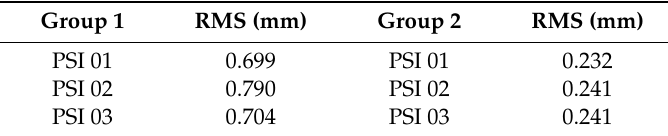
Table 5. Quantitative assessment of dimensional accuracy of FFF 3D printed PEEK patient-specific implants (PSIs) regarding root mean square (RMS) values (mm).